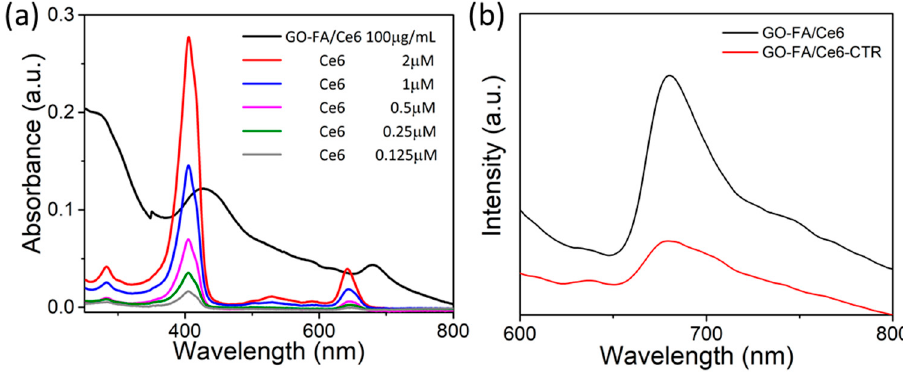
Figure 1. ( a ) UV-Vis spectra of GO–FA/Ce6 and Ce6 alone at different concentrations in water and ( b ) fluorescence spectra of GO–FA/Ce6 and GO–FA/Ce6–CTR dispersed in water at 10 μ g/mL ( λ ex = 420 nm).